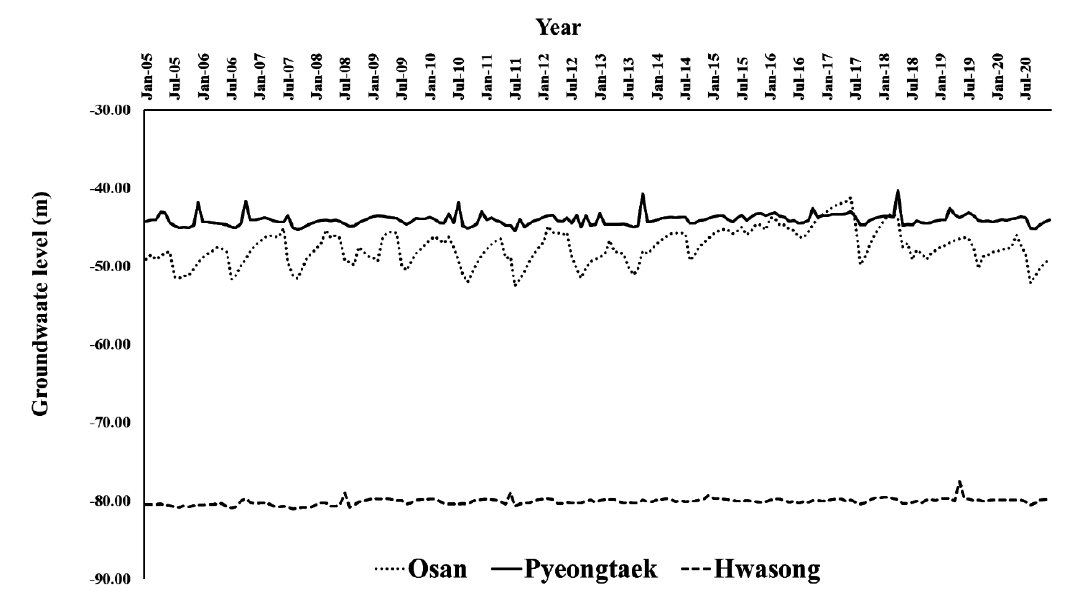
Figure 4. Average observed values for groundwater levels in the Osan watershed.